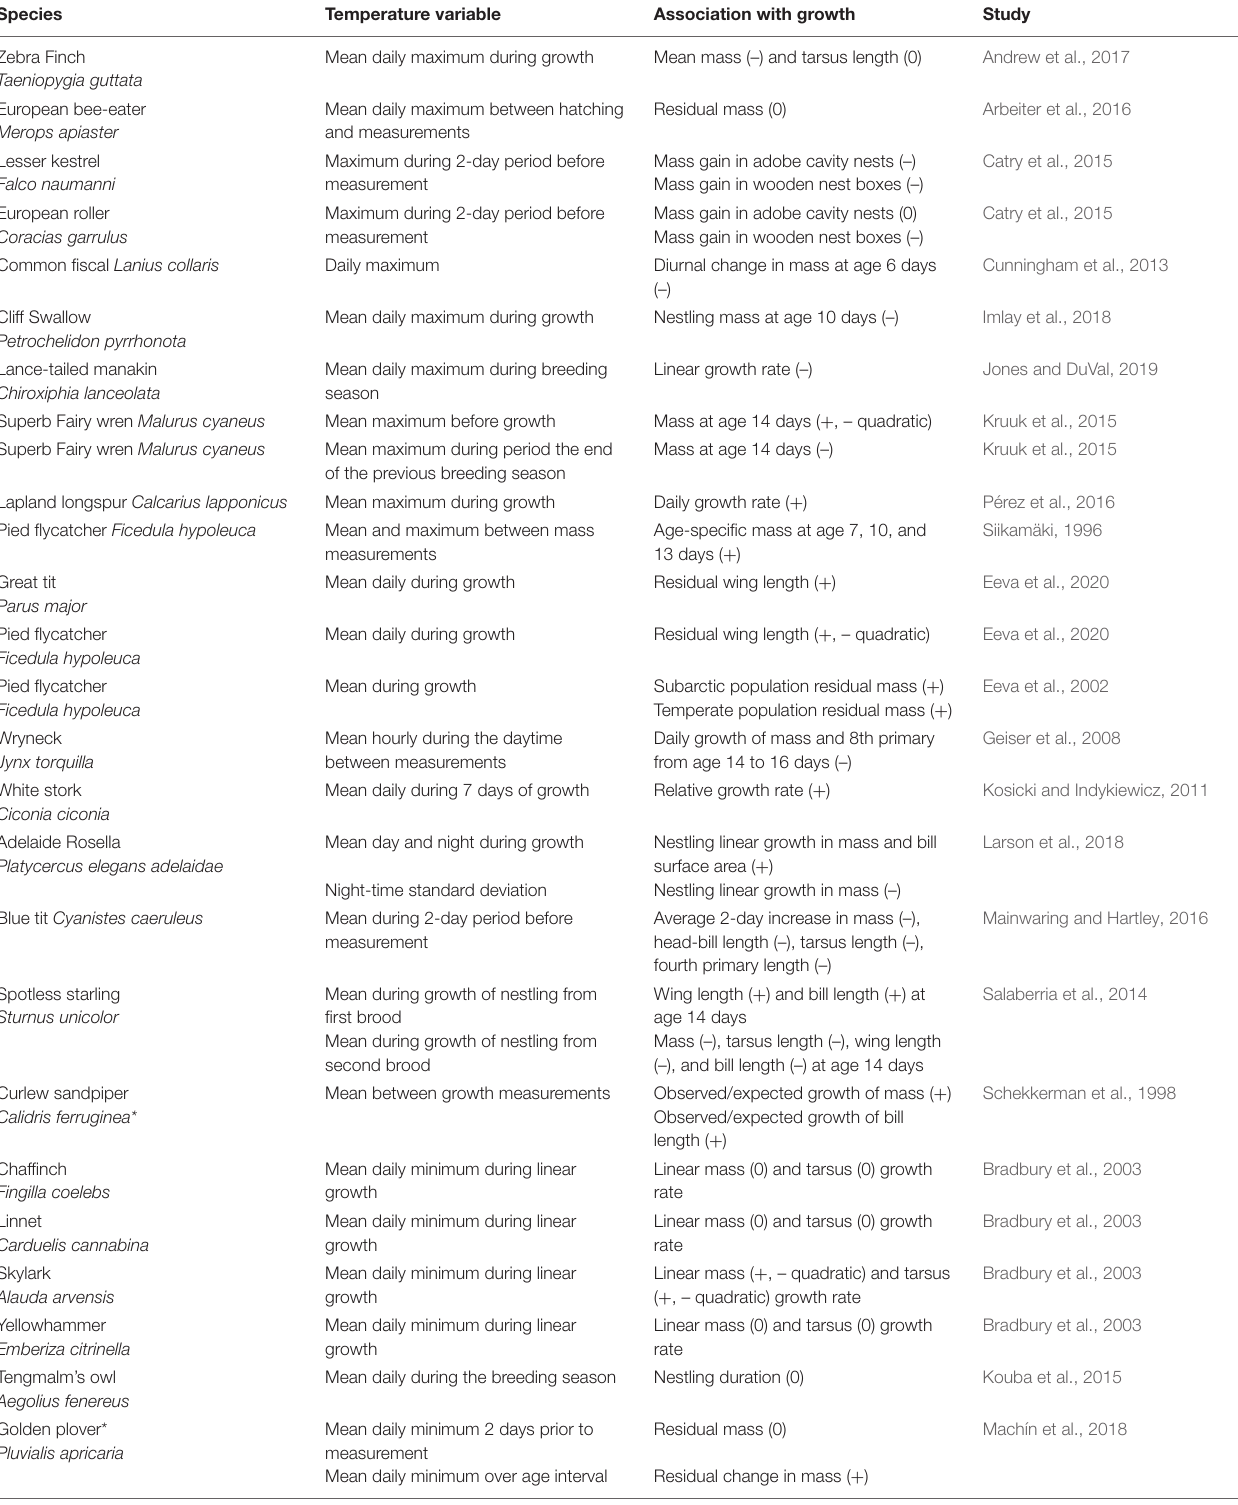
TABLE 1 | Associations between aspects of temperature and nestling growth traits identified from our literature